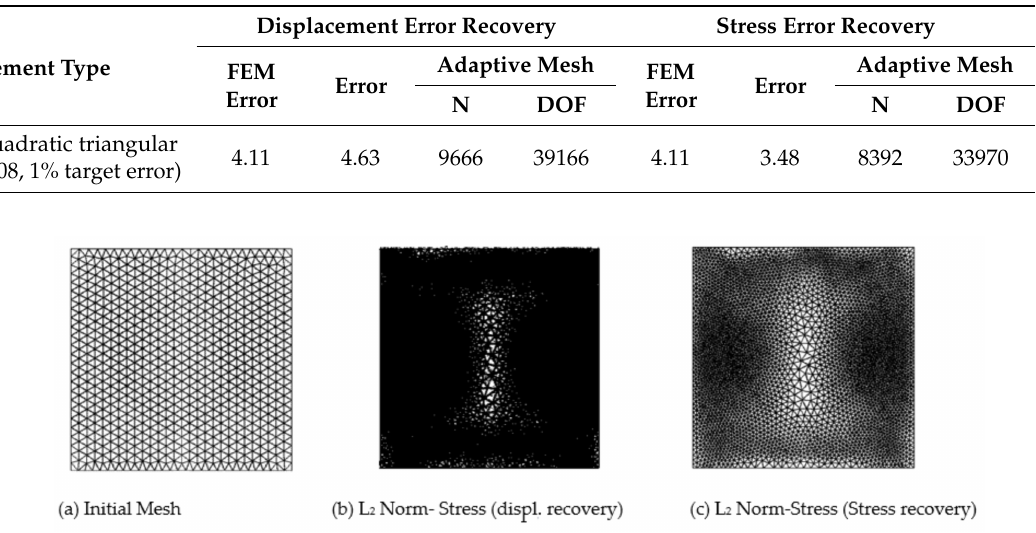
Table 11. Global errors (FEM and processed, L 2 -Norm) and number of elements (N) with DOF of adaptively refined meshes considering displacement and stress recovery-based analysis.